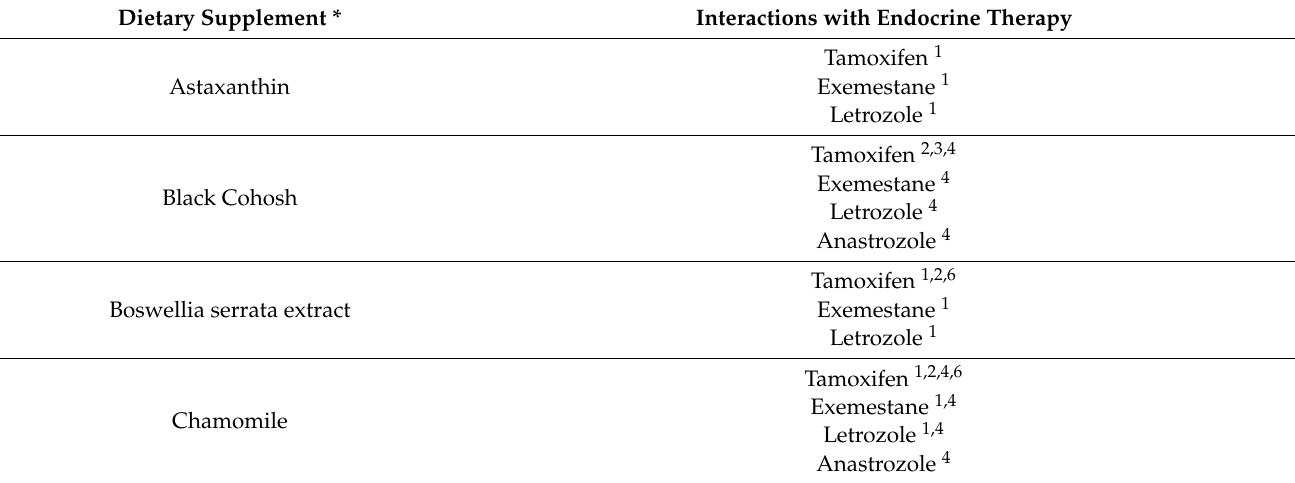
Table 4. Potential Interactions with endocrine